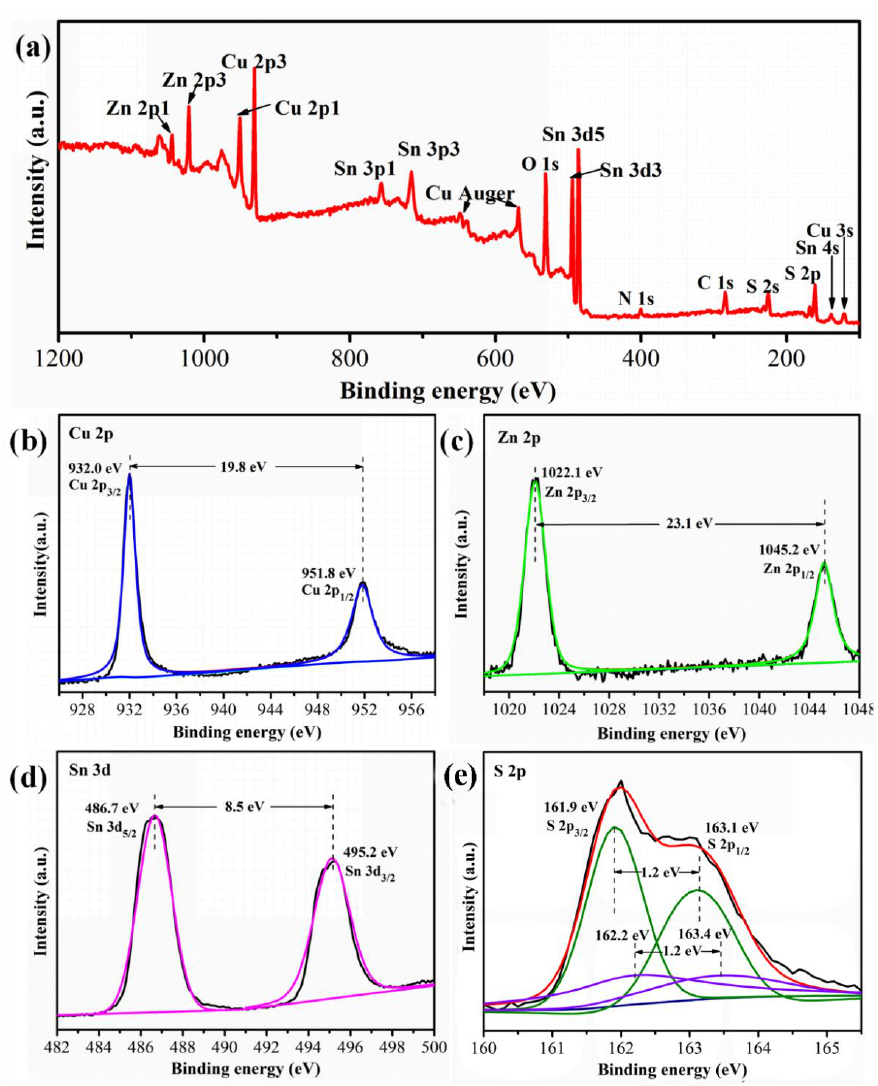
Figure 5. ( a ) XPS survey spectra of CZTS-24 h and the high-resolution XPS spectra of ( b ) Cu 2p, ( c ) Zn 2p, ( d ) Sn 2p and ( e ) S 1s. Table 1. Elemental composition of CZTS nanoparticles obtained at different reaction time.